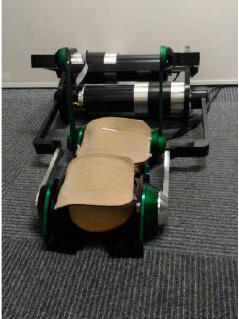
Figure 1. Image of the training robot.